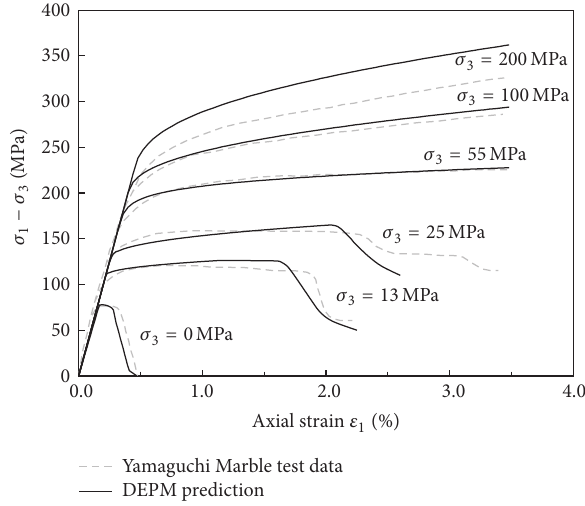
Figure 2: Stress-strain relationships of Yamaguchi Marble under triaxial compression by DEPM prediction (this study) and test